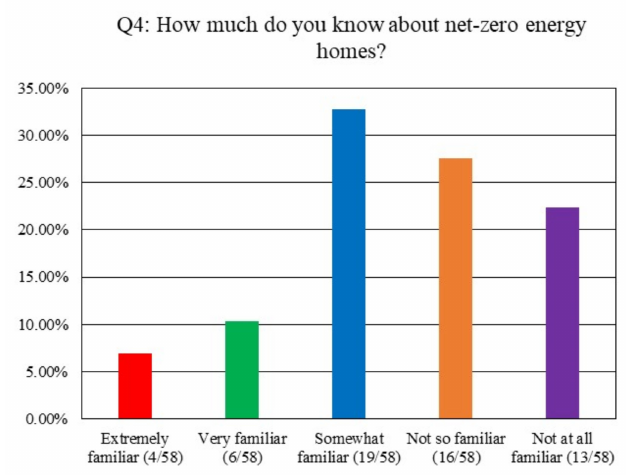
Figure 5. Participants’ knowledge on net-zero energy homes (degree of familiarity).